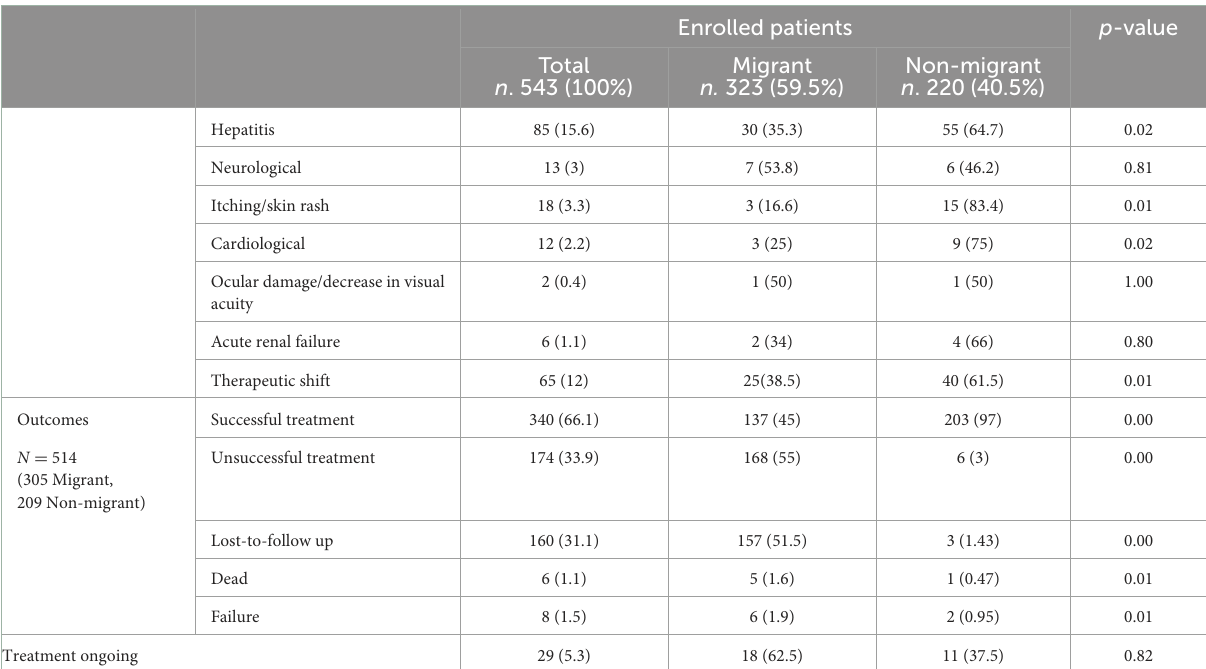
The univariate and multivariate analyses on treatment outcomes included the following variables: migrant status, age, gender, homelessness, presence of respiratory symptoms, diagnostic delay, length of hospitalization, drug resistance, treatment regimen, TB localization (lung or extrapulmonary), and TB culture positivity. Significant predictors of unsuccessful treatment are reported in Table 2. Independent factors of unsuccessful treatment (death, treatment failure or loss to follow up) were: migrant status (O.R. = 11.31; 95% CI 9.72–14.23),